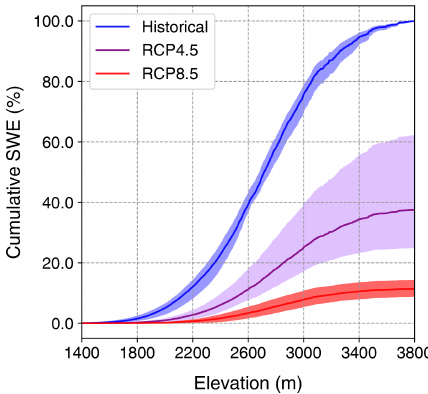
Figure 11. Distribution of cumulative basin-wide peak SWE with elevation in the GCM-driven experiments, under the historical (black), RCP4.5 (purple) and RCP8.5 (red) scenarios. SWE is normalised in each model by that model’s historical total basin- wide SWE.